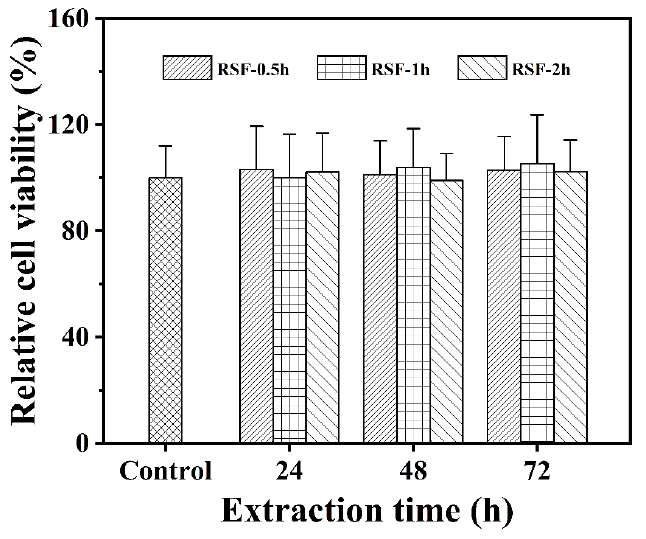
Figure 4. Effects of silk fibroin hydrogel extracts on the viability of HepG2 cells. Meanwhile, the cell morphology of the experimental group and the control group was photographed with an inverted microscope to assist in verifying the results of the MTT analysis. The photographing situation is shown in Figure 5. After 48 h of co-incuba- tion, the experimental group was compared with the control group. It was found that the cells grew well as a whole, and a large number of living cells proliferated and diffused successfully, presenting a consistent spindle shape, which further confirmed the detection results of the MTT method. These results indicated that the silk fibroin hydrogel had ex- cellent biocompatibility and was suitable for controlled drug release or as a wound dress- ing carrier in biomedicine [30–32].